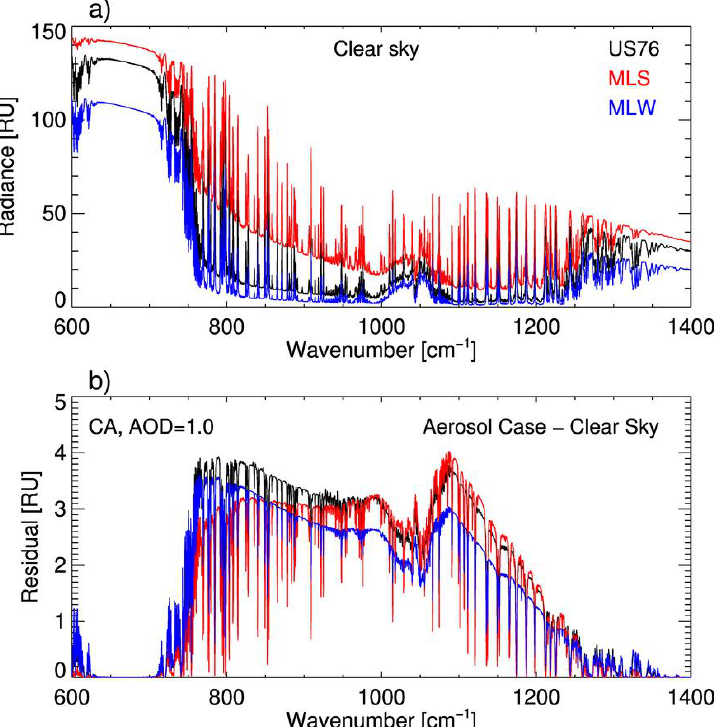
Figure 4. ( a ) The simulated clear sky radiance from LBLDIS for different atmosphere models, US76 (black), MLS (red), and MLW (blue). ( b ) The residual radiances between clear sky and turbid aerosol conditions. The aerosol was set as 1.0 of AOD for CA. The “radiance unit (RU)” is 1 mW/(m 2 sr cm −1 ).